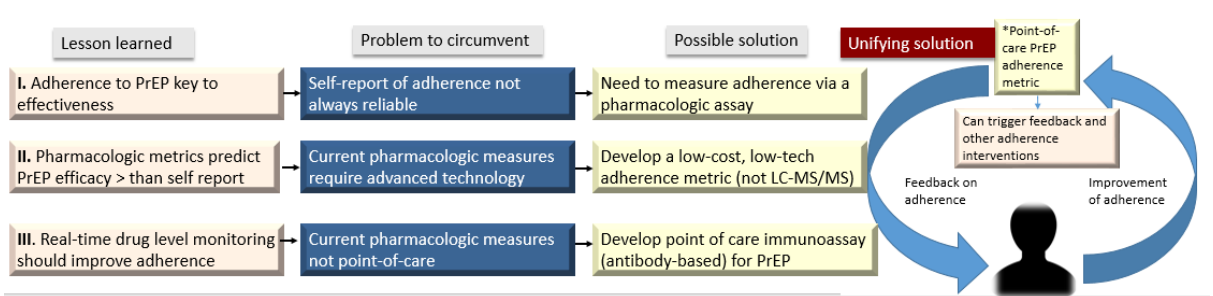
Figure 1. The rationale behind the PUMA study. PUMA: Point-of-Care Urine Monitoring of Adherence; PrEP: preexposure prophylaxis; LC-MS: liquid chromatography/tandem mass